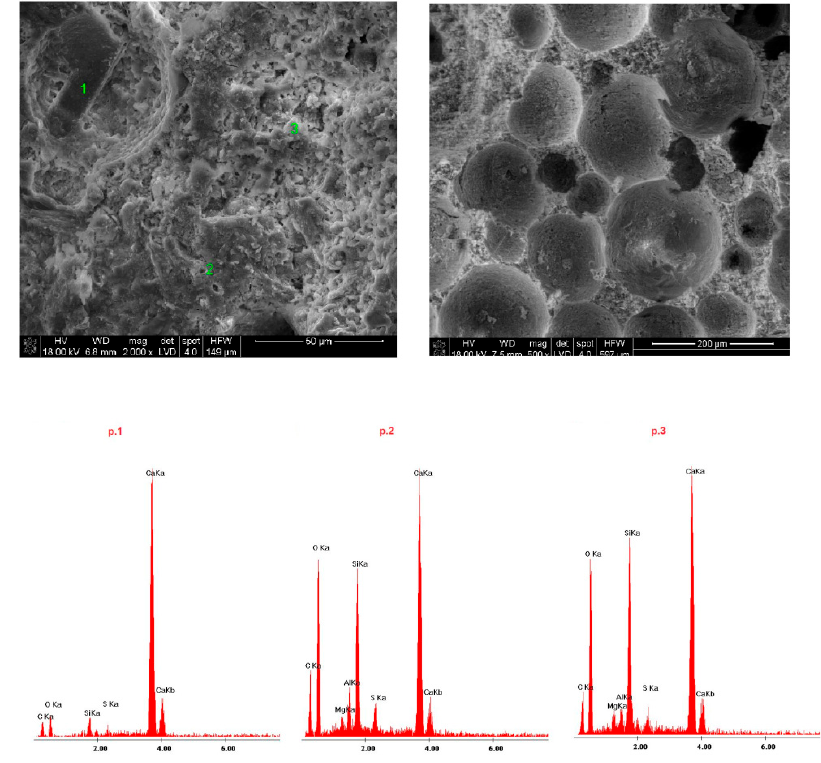
Figure 12. SEM microphotograph and EDS analysis of sample 4.